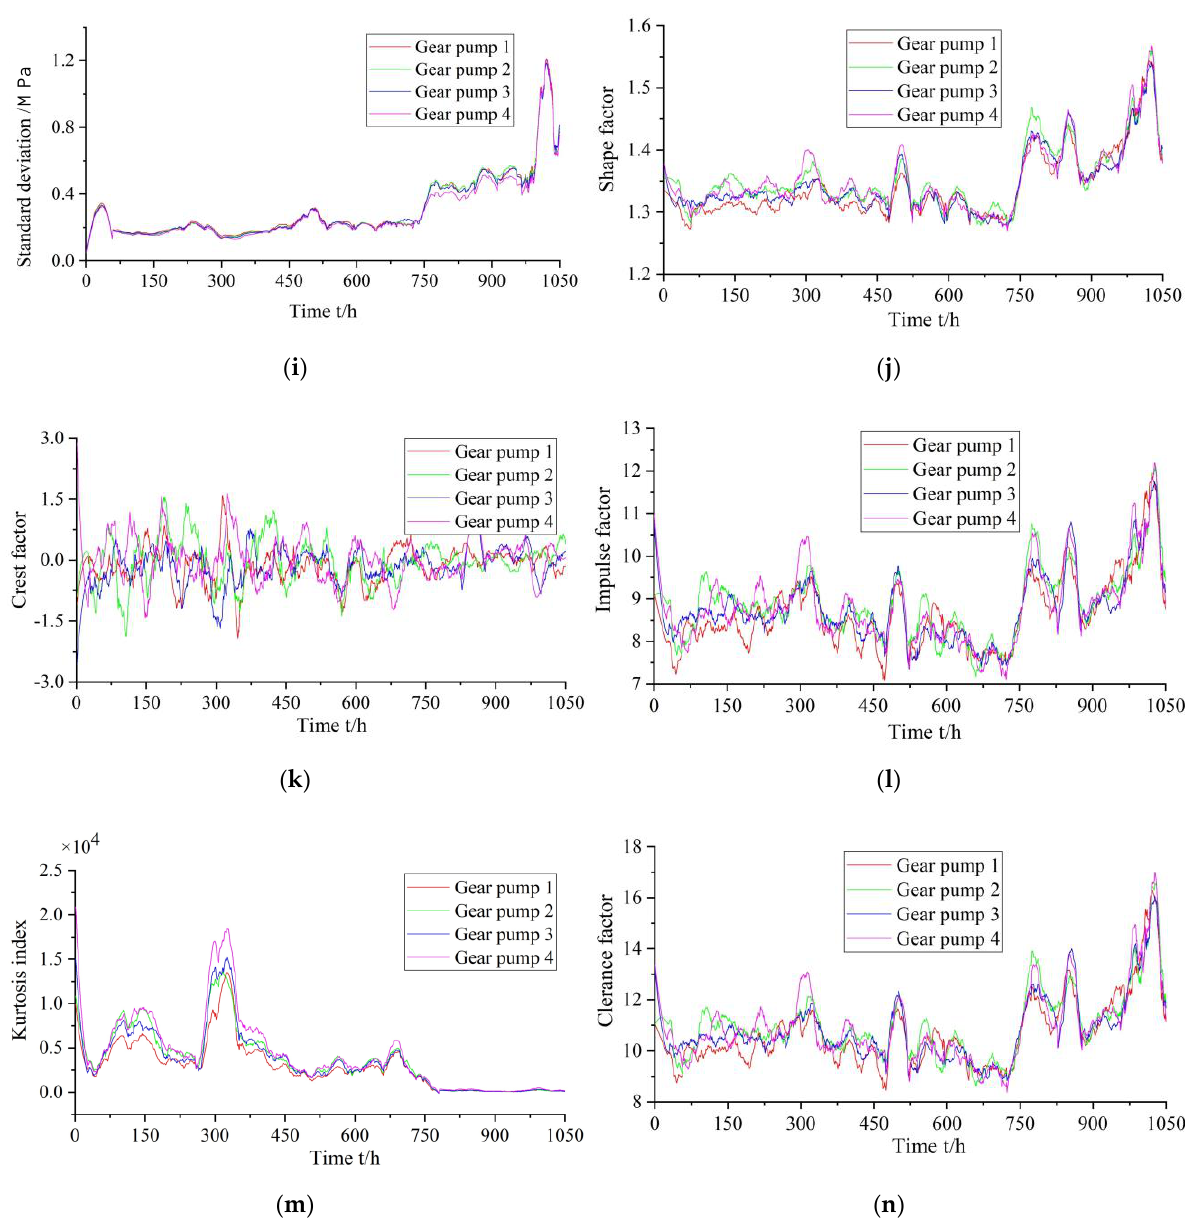
Figure 8. Time-domain characteristic parameters: ( a ) Mean value; ( b ) Variance; ( c ) Root-mean-square value; ( d ) Kurtosis; ( e ) Peak value; ( f ) Root amplitude; ( g ) Peak-to-peak value; ( h ) Absolute mean value; ( i ) Standard deviation; ( j ) Shape factor; ( k ) Crest factor; ( l ) Impulse factor; ( m ) Kurtosis index; and ( n ) Clearance factor.